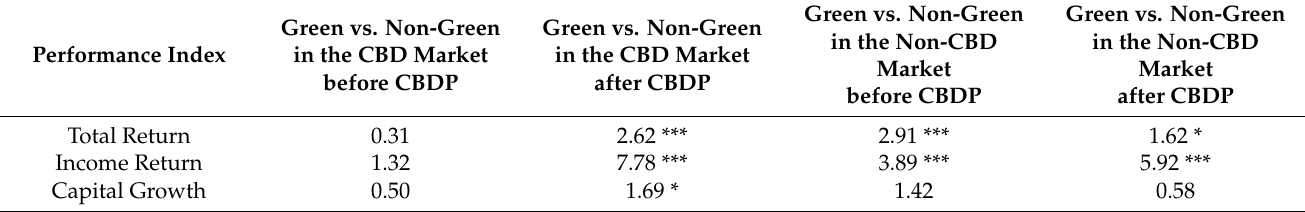
Table 7. CBD and non-CBD markets: parametric t -value of non-green (0–3.5 stars) vs. green (4–6